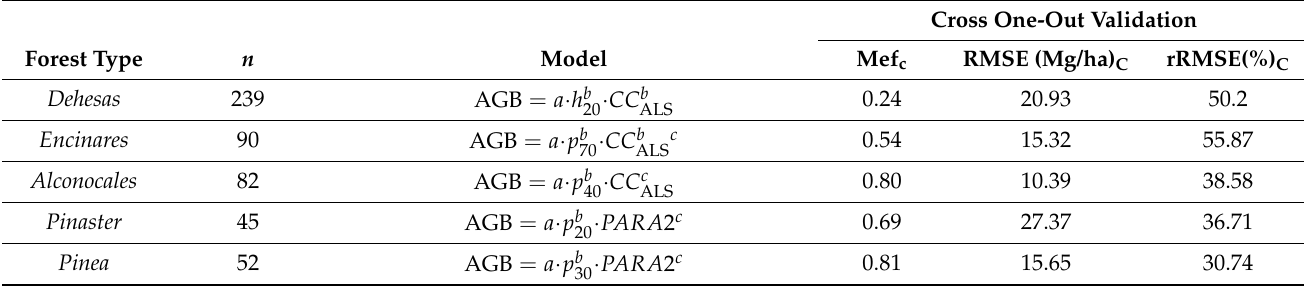
Table A1. Summary of absolute and relative RMSE for the calibrated ALS model and LOOCV AGB predictions stratified by vegetation; n = number of observations (field plots) per